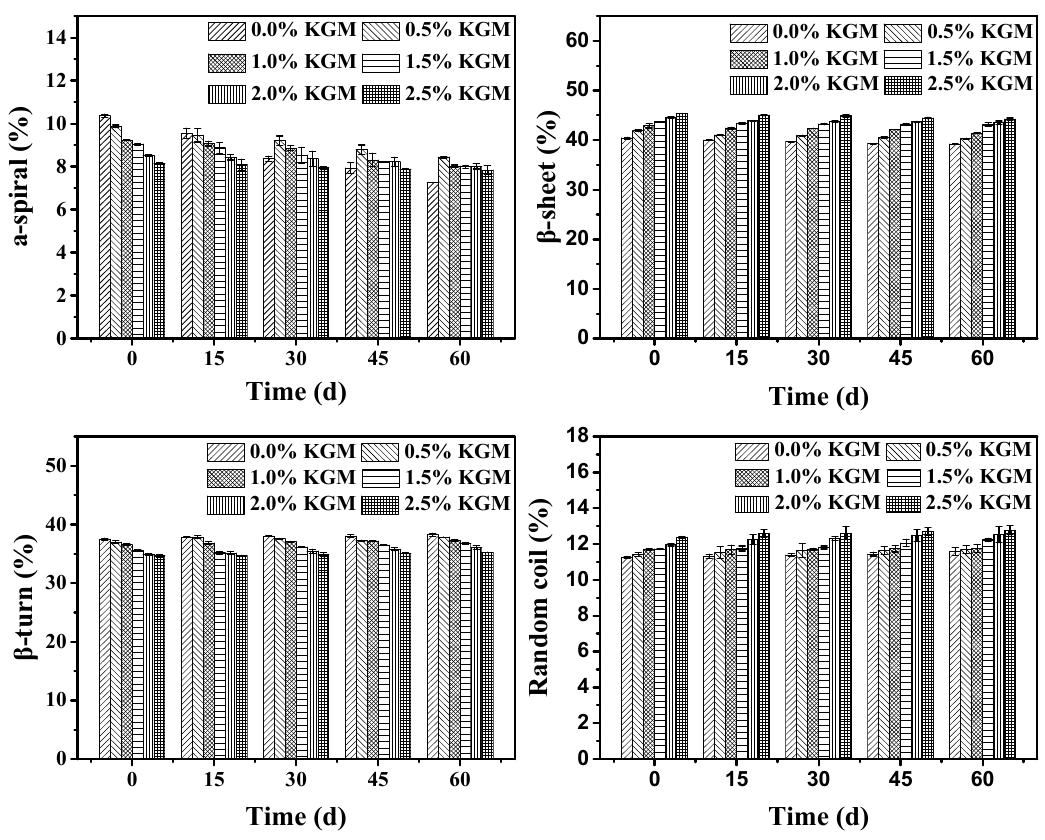
Figure 2. Secondary structure changes of gluten proteins with different proportions of KGM added during frozen storage.